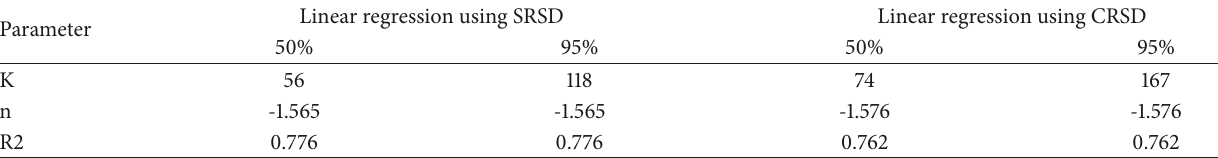
Table 3: Determined parameters for square root and cube root equations with confidence levels (50%, 95%). Linear regression using SRSD Linear regression using CRSD Parameter 50%